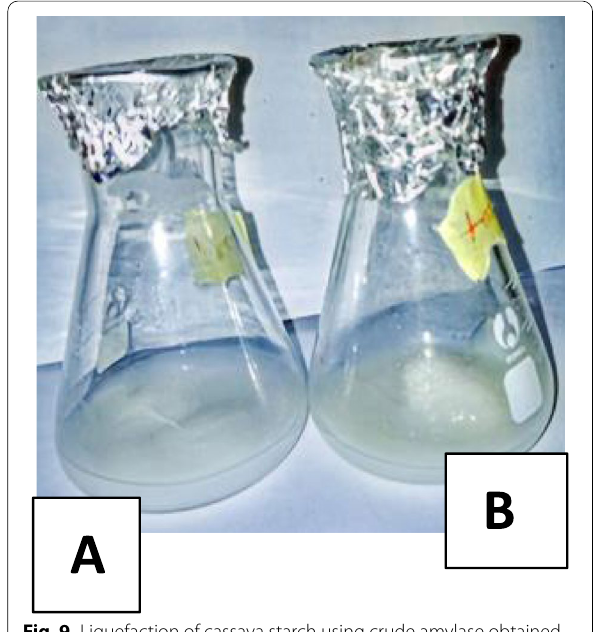
Fig. 9 Liquefaction of cassava starch using crude amylase obtained from the submerged fermentation of Pleurotus tuberregium . A Glucose released from starch with the use of crude amylase